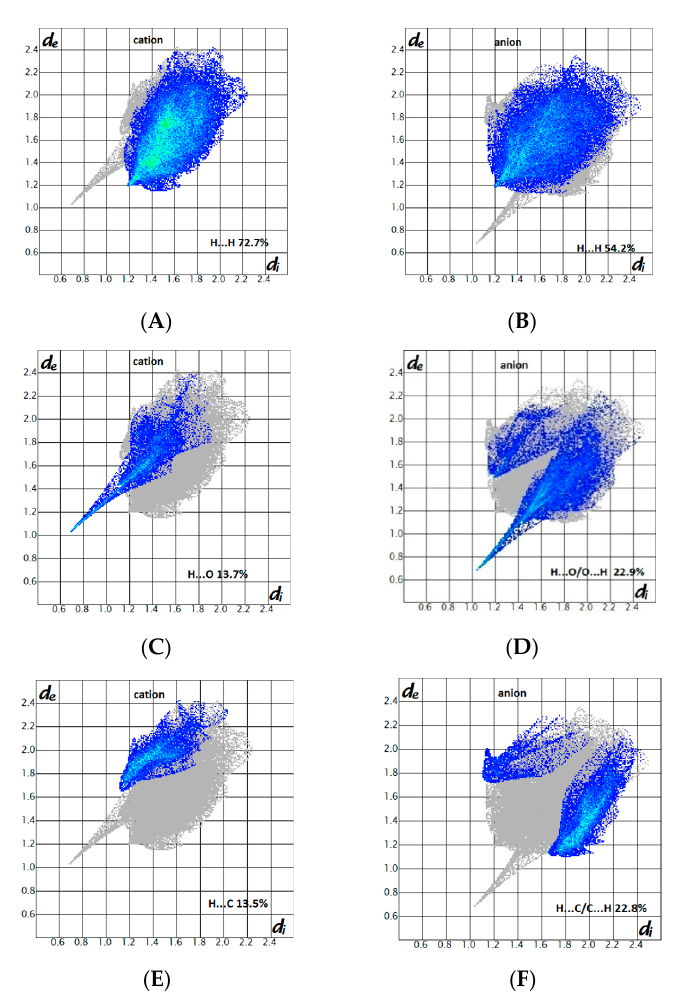
Figure 10. Full fingerprint plot of the cation ( A ) and anion ( B ).